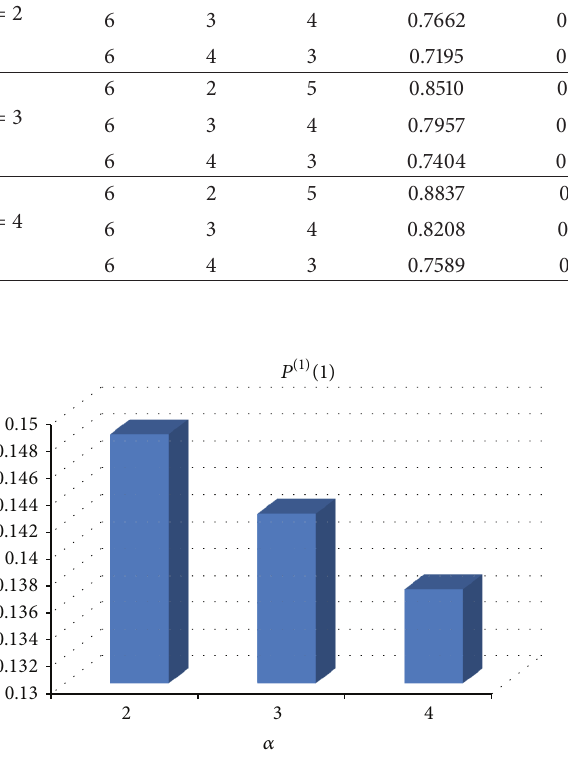
Figure 2: Effect of breakdown parameter 𝛼 on the probability that the server is providing service in mode 1 (when 𝛽 = 6 , 𝛾 = 2 , 𝜂 = 5) .